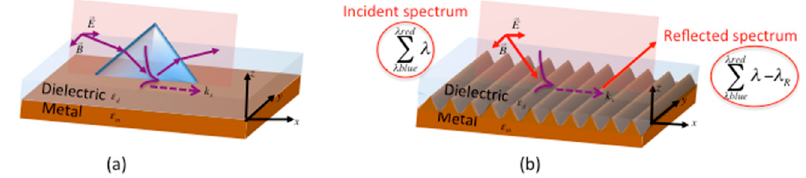
Figure 1. Principle of plasmon coupling at a metal-dielectric interface by ( a ) prism and ( b ) surface structuration.